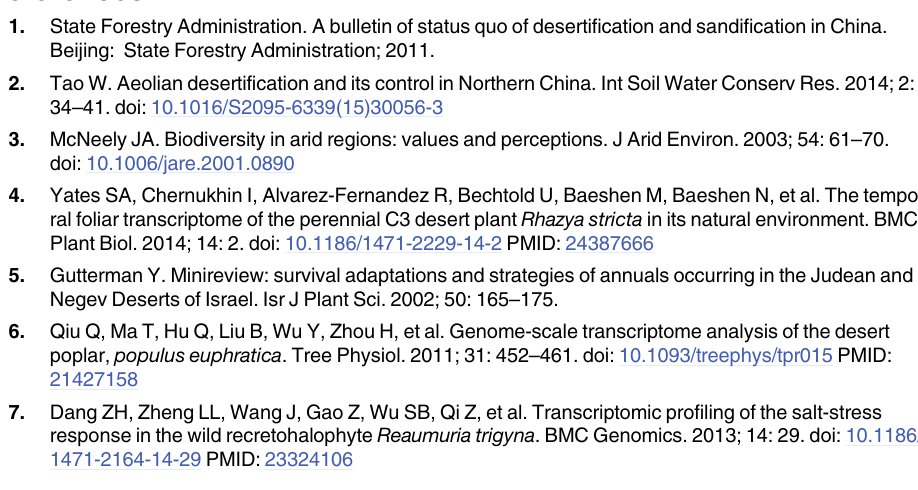
S7 Table. HSPs in the Artemisia sphaerocephala transcriptome. S8 Table. Highly expressed heat-responsive unigenes. S9 Table. Fifteen HSFs in Artemisia sphaerocephala . S10 Table. Highly expressed cold-responsive unigenes. S11 Table. Highly expressed salt-responsive unigenes. S12 Table. Highly expressed hyperosmotic — responsive unigenes. S13 Table. Possible genes involved in multiple stress responses. S14 Table. Pairs of putative orthologs between Artemisia sphaerocephala and Arabidopsis thaliana .